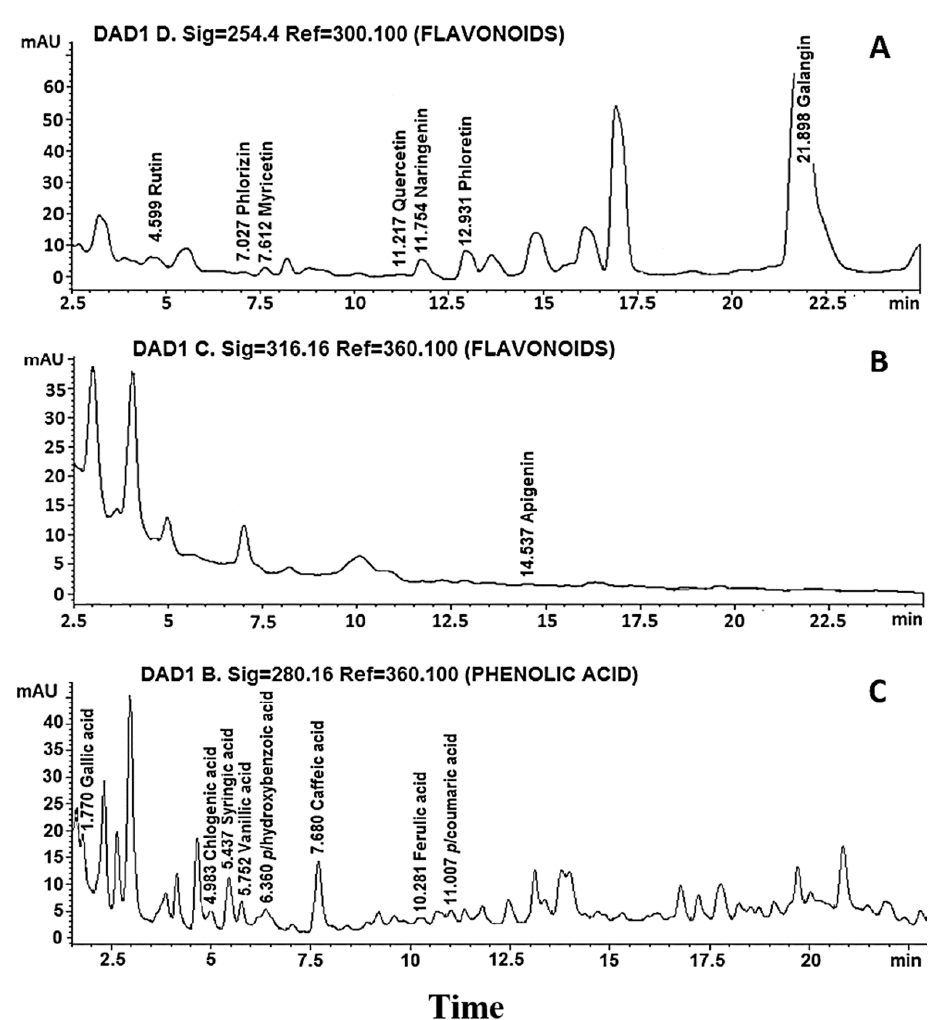
Figure 1. Identification of compounds present in the H387 07 hybrid fruit extract by HPLC. ( A ) Chromatograms of the flavonoids at 254 nm; ( B ) presence of apigenin at 316 nm and unidentified compounds; and ( C ) phenolic acids at 280 nm.